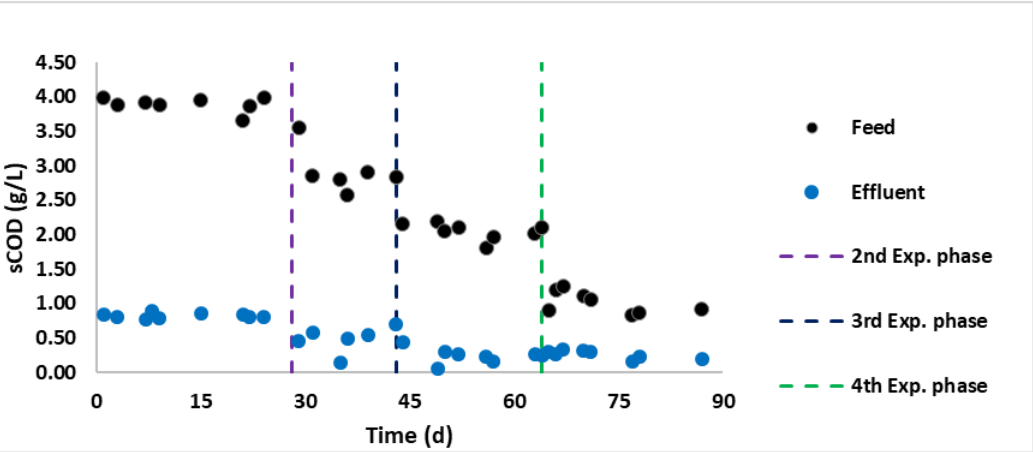
Figure 14 . Daily sCOD values of the reactor ’ s feedstock and effluent. Figure 14. Daily sCOD values of the reactor’s feedstock and effluent.